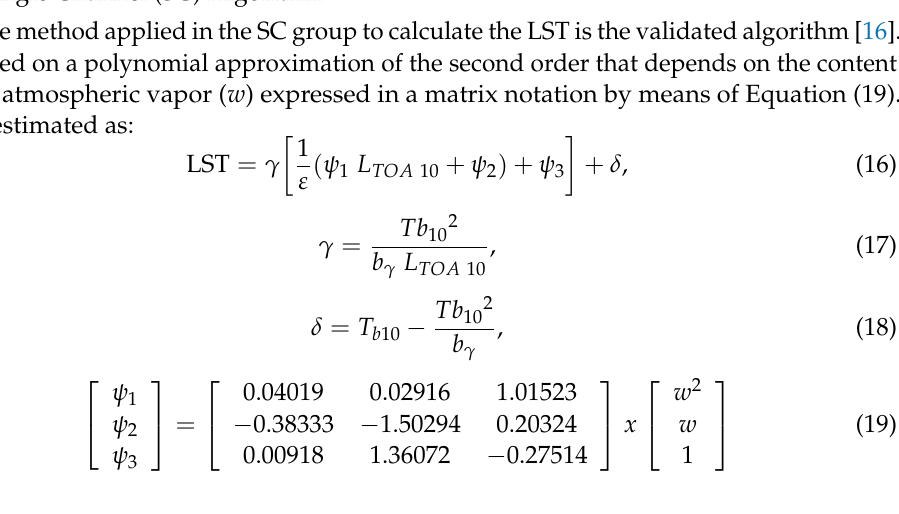
Table 4. Air pollution index (API) limit